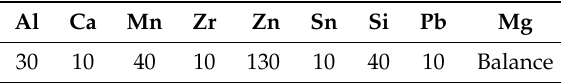
Table 1. Composition of pure magnesium in ppm.